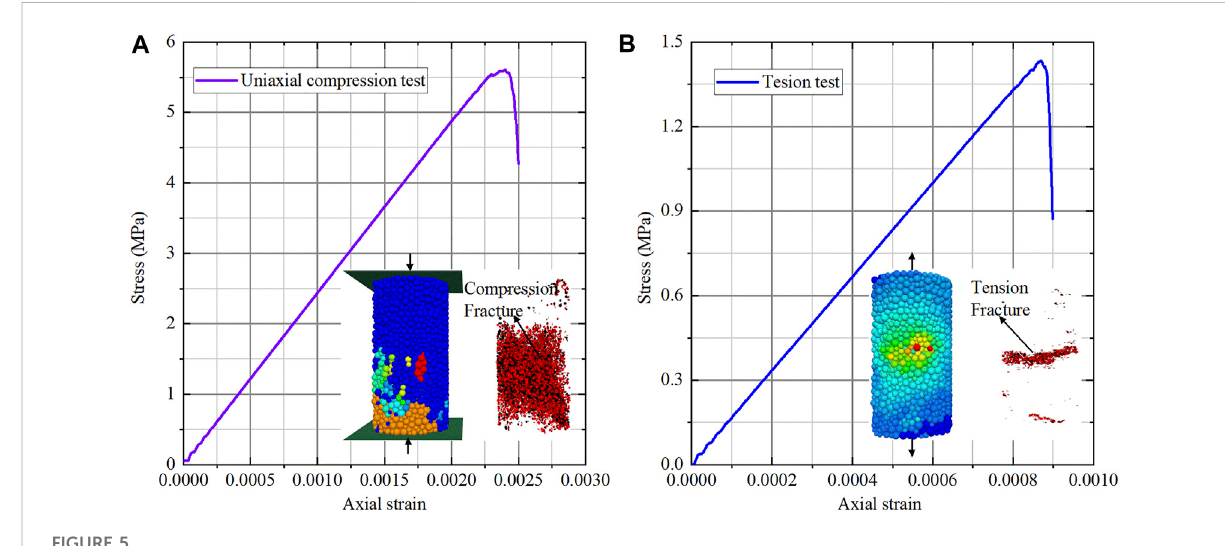
FIGURE 5 Simulated PFC3D failure in (A) UCS and (B) tension test.